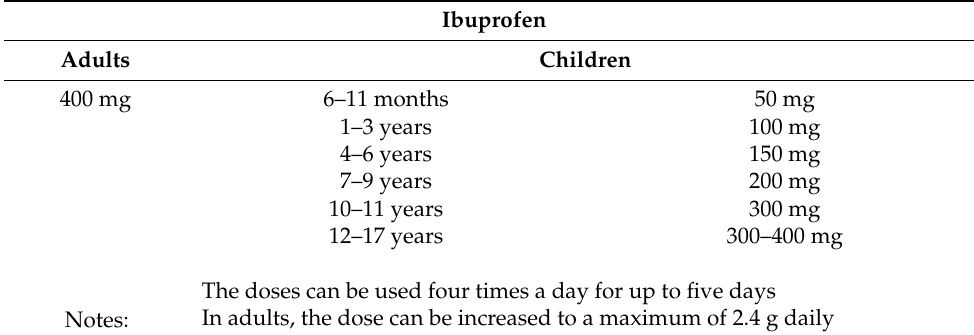
Table 4. Oral analgesic prescription for